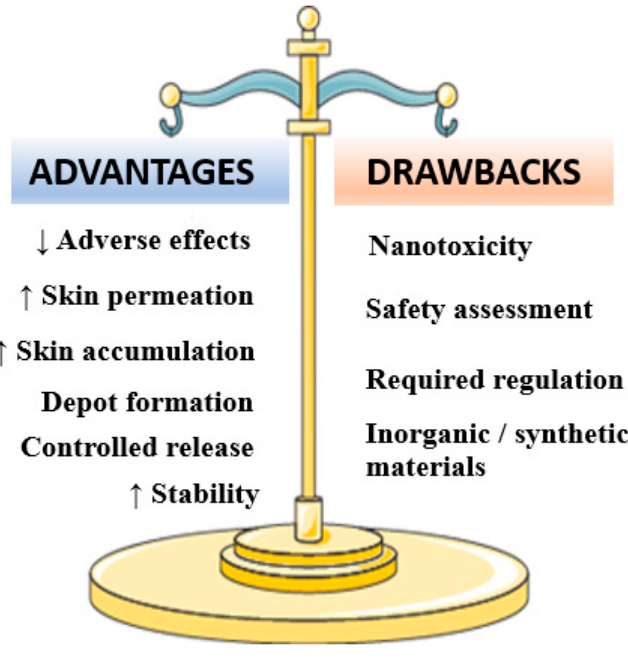
Figure 3. Major advantages and drawbacks associated to minoxidil-loaded nanotechnology-based formulations.